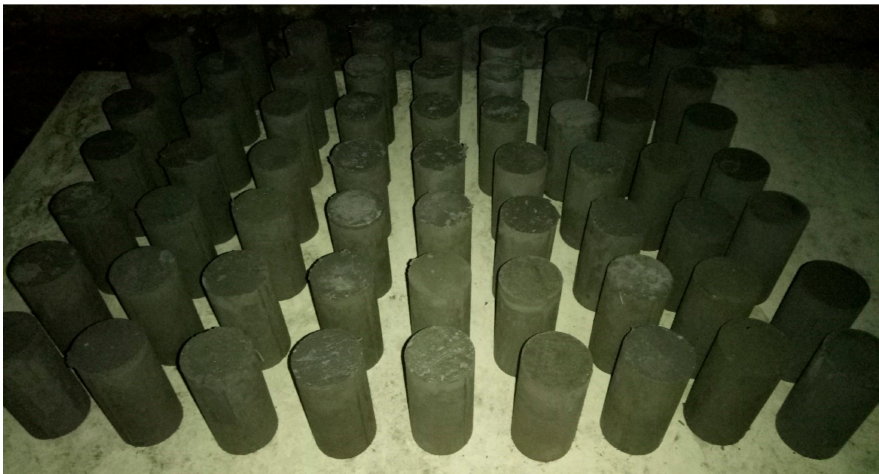
Figure 2. The cemented paste backfill (CPB) specimens for the unconfined compressive strength (UCS)